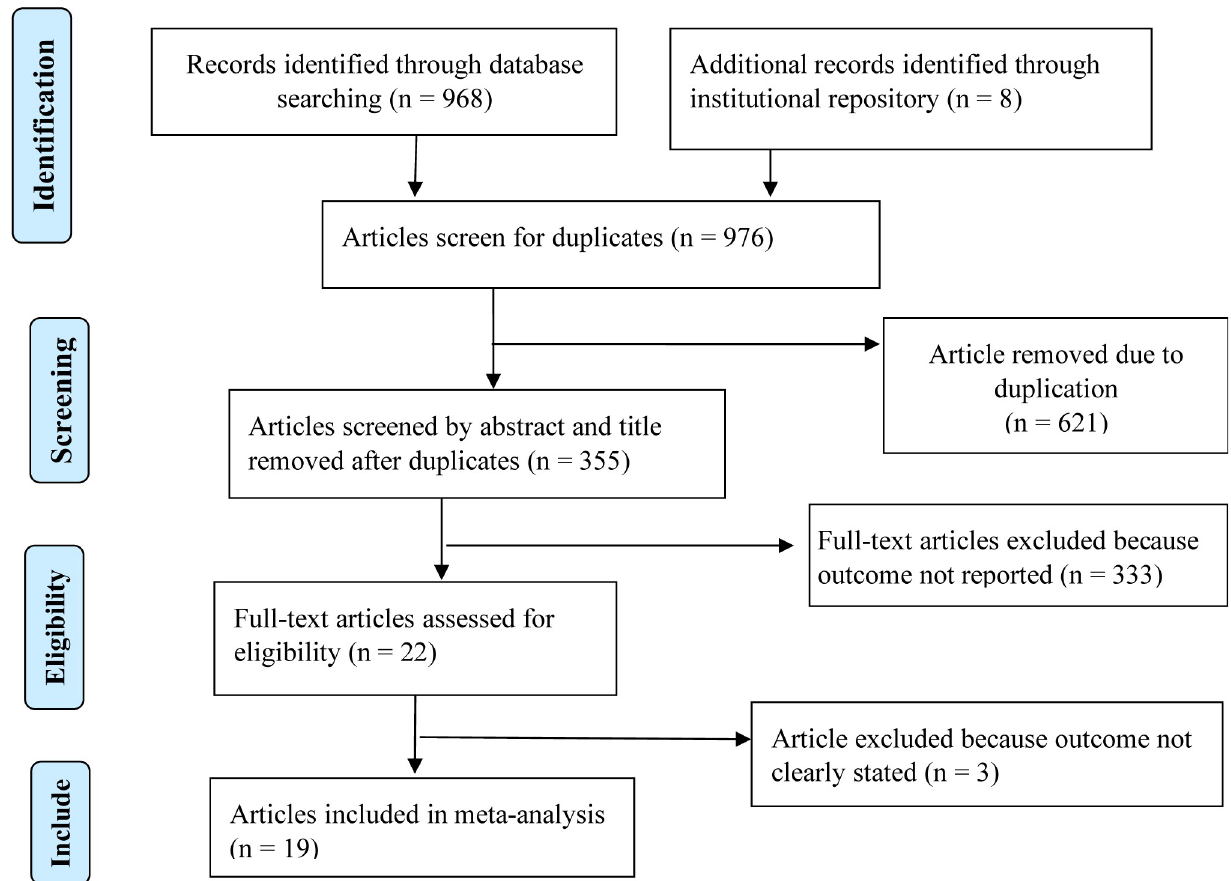
Fig 1. PRISMA statement presentation for a meta-analysis of a pooled proportion of dietary adherence among type 2 DM in Ethiopia, 2012–2020.